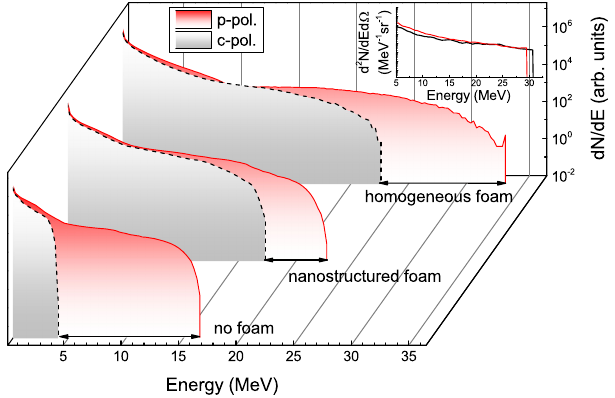
FIG. 5. Calculated proton energy spectra from homogeneous foam, nanostructured foam, and Al foil using p - and c - polarized laser pulse. The inset shows the corresponding experimental